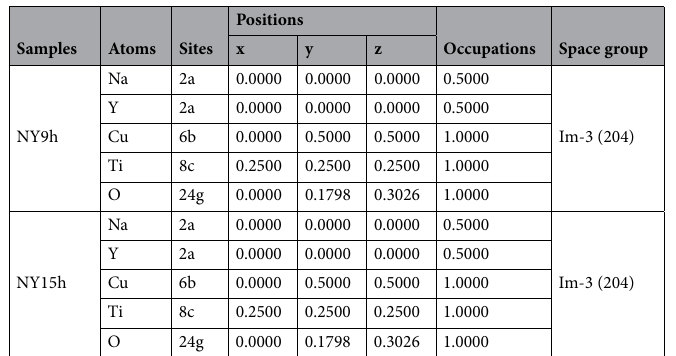
Table 1. Atomic positions of Na, Y, Cu, Ti and O, occupation, and space group of the NY9h and NY15h ceramics.